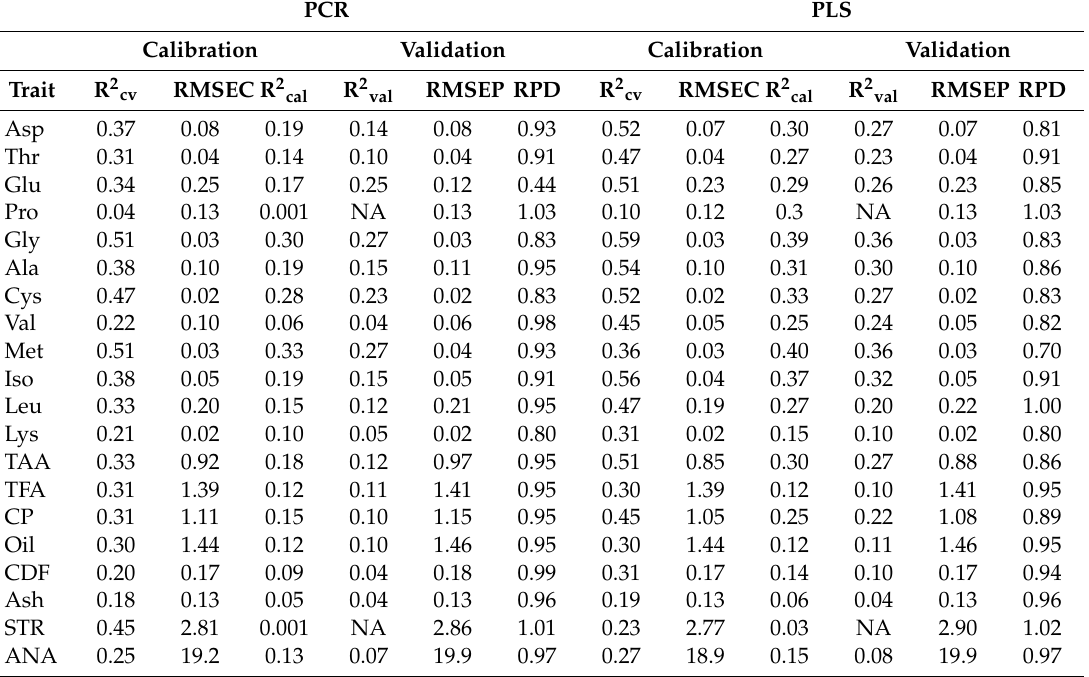
Table 5. PCR and PLS model results of calibration and validation for twenty di ff erent constituents (1st Derivative) of blue maize grain samples. Coe ffi cient of determination (R 2 ) of actual (R 2 cal ) and predicted (R 2 val ) constituent values. Ratio of performance to the standard deviation